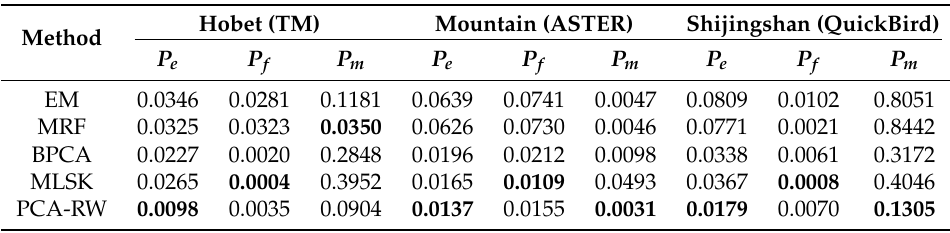
Table 2. Error rate ( P e ), false-alarm rate ( P f ) and missed-alarm rate ( P m ) in percentage achieved by different change detection methods on the three data sets (Hobet, Mountain,